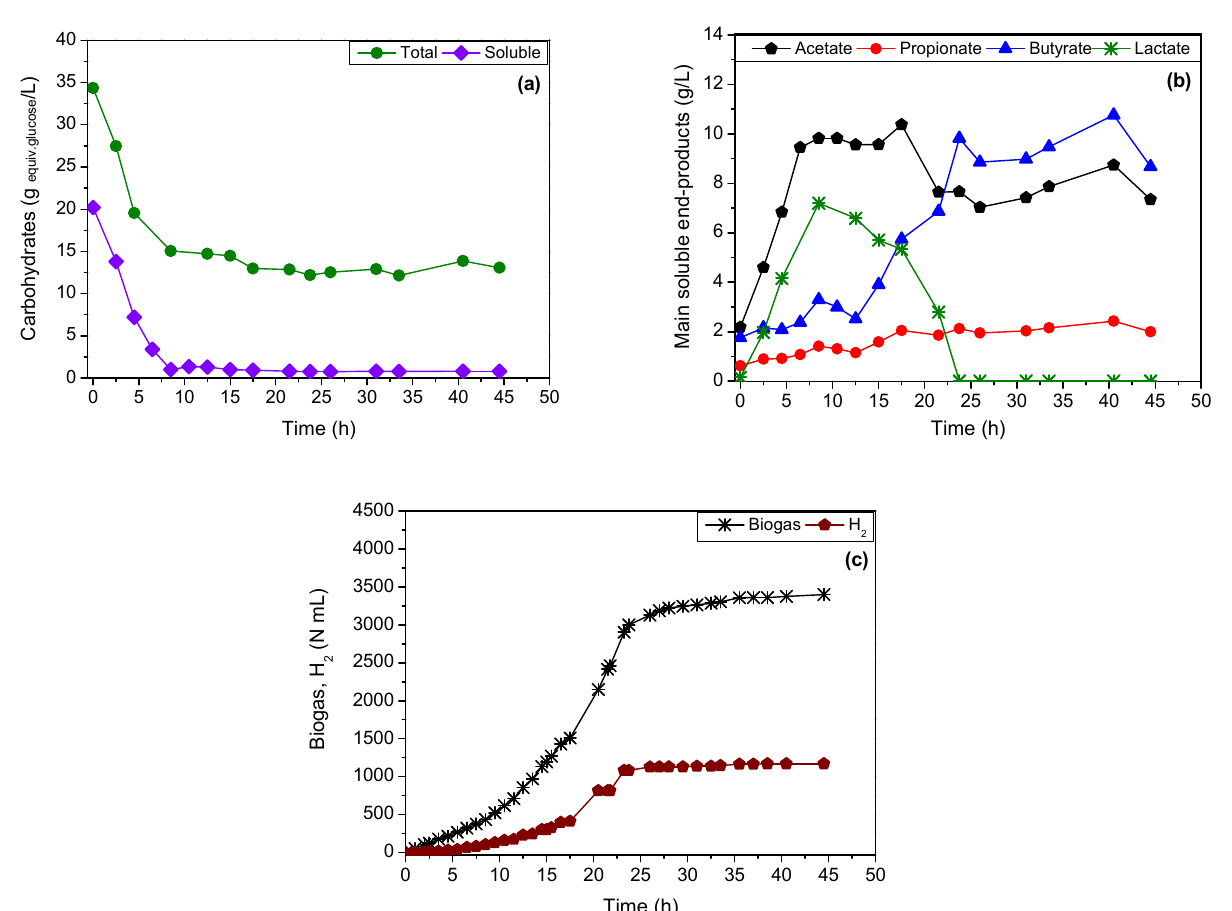
Figure 3. ( a ) Consumption of carbohydrates; ( b ) evolution of main VFAs and lactic acid and ( c ) gaseous products (biogas and hydrogen) during batch acidogenesis of agro-waste mixture (in ratio of 55:40:5), at pH 5.5.